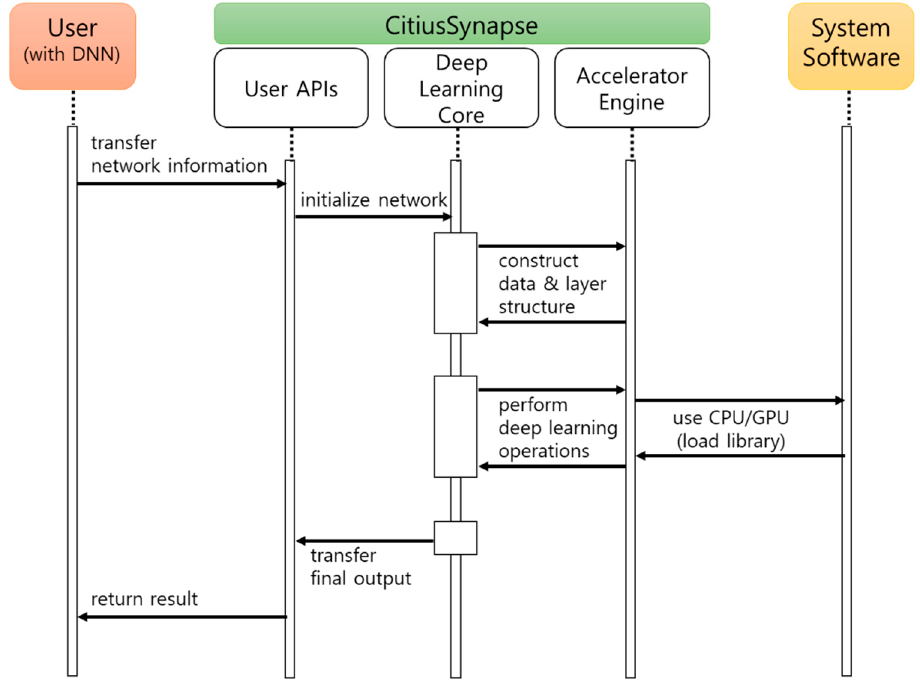
Figure 2. Interaction flow of framework components.